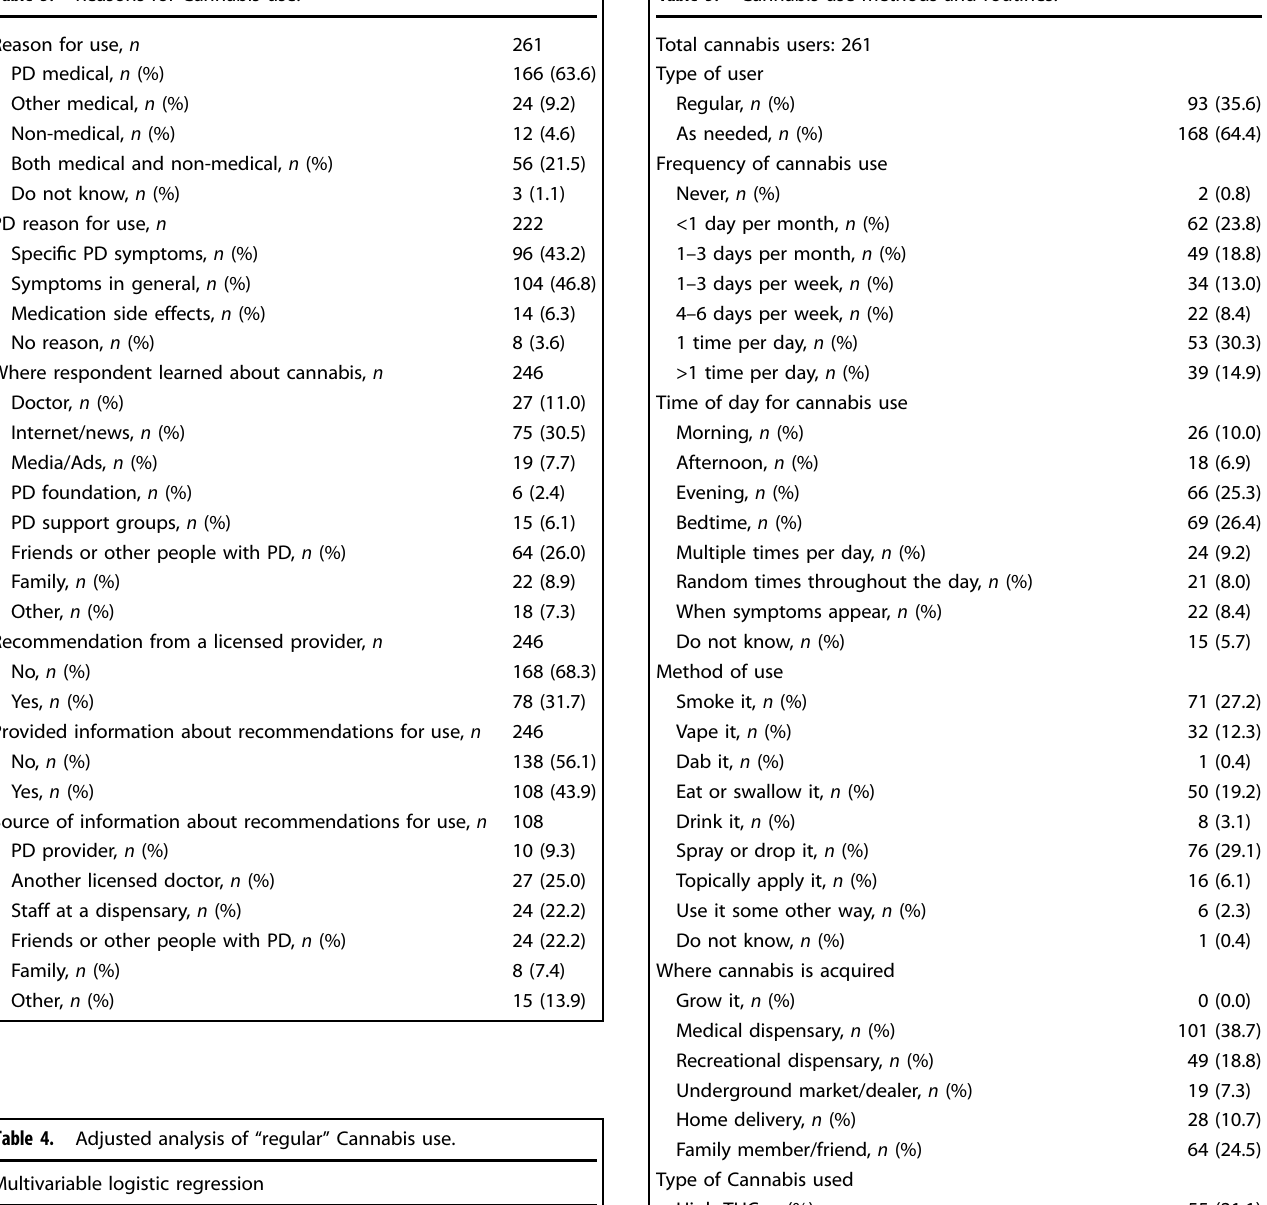
Table 5. Cannabis use methods and